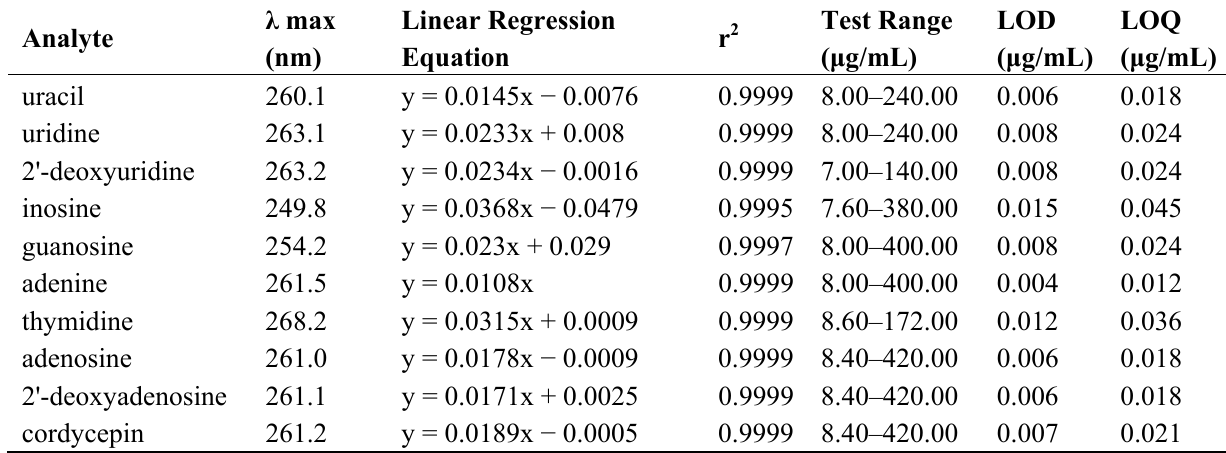
Table 6. Linear regression data, LOD, and LOQ of 10 nucleosides at 260